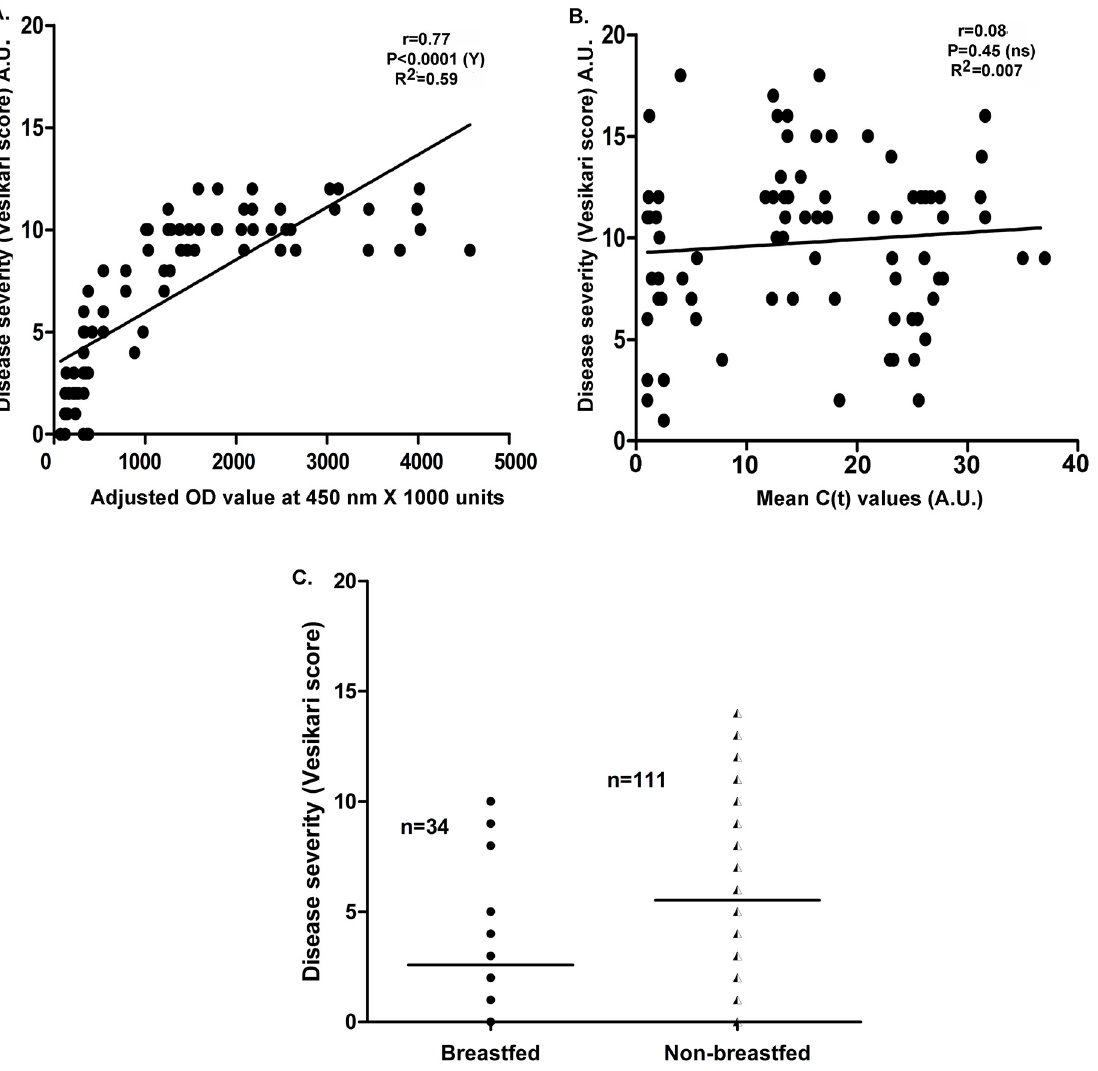
Fig 6. Correlation of Rotavirus antigenemia and RNAemia with disease severity. (A-B) Correlation of disease severity with Rotavirus antigenemia (A) and Rotavirus RNAemia (B) in infants suffering from acute gastroenteritis and diarrhea.(C) Breastfeeding wise stratified data of disease severity among the breastfed and non-breastfed group of infants. Disease severity is represented by Vesikari scores (0 – 20) according to the 20 point Vesikari scoring system, as mentioned in the